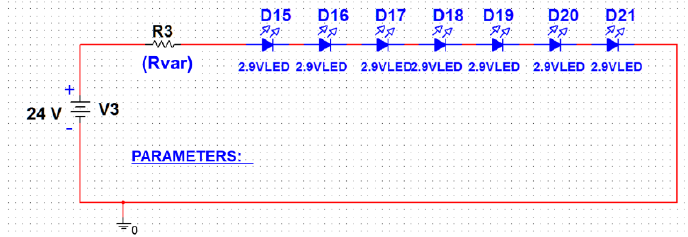
Figure 7 is a single circuit diagram with a variable resistor and 7 LEDs connected in series. Figure 7. Plant growth LED module design single circuit. Figure 7. Plant growth LED module design single circuit.